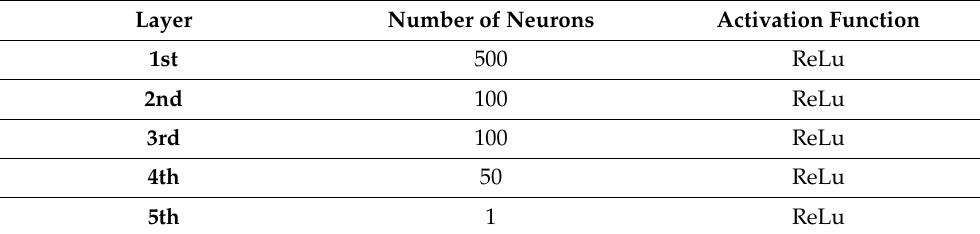
Table 1. MLP configuration.